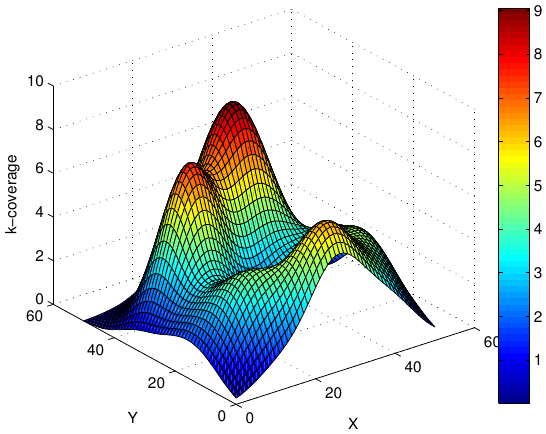
Figure 11. The improved coverage via activated actuators.